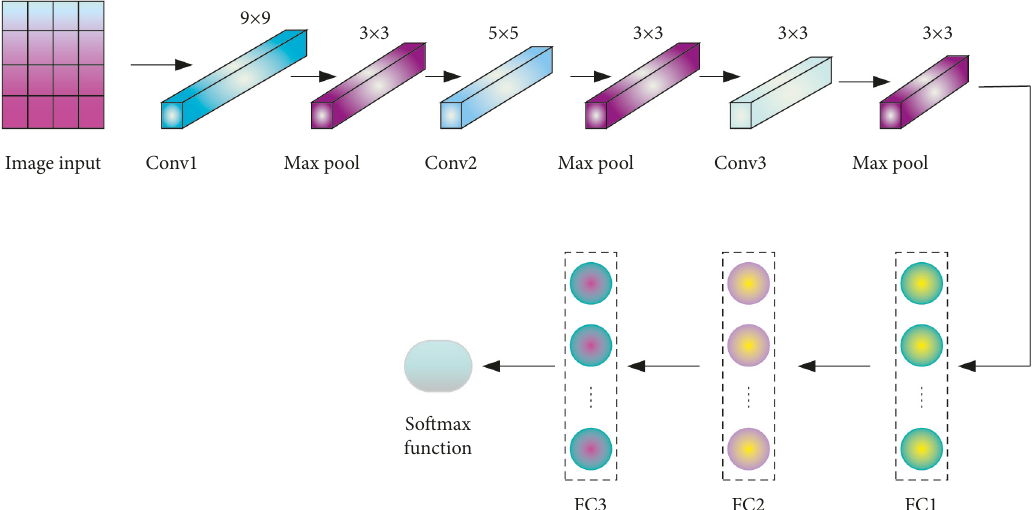
Figure 10: Structure diagram of optimized image classification